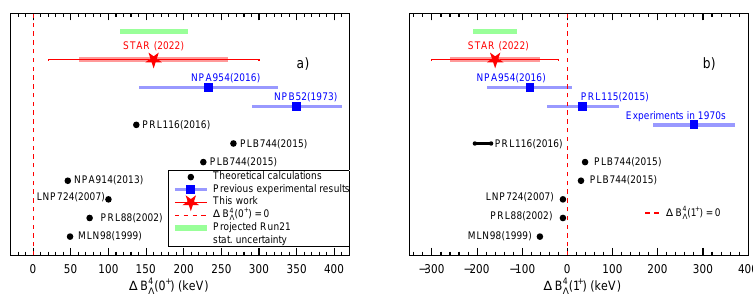
Figure 2. The Λ binding energy di ff erence between 4 Λ H and 4 Λ He in ground states (left figure) and in excited states (right figure) compared with theoretical model calculations (black dots) [5–10] and previous measurements (blue squares) [1–4, 16]. Error bars show statistical uncertainties and shaded bands show the systematic uncertainties. The green shadows are projected statistical uncertainties for the 3 GeV data taken in 2021. This figure is from